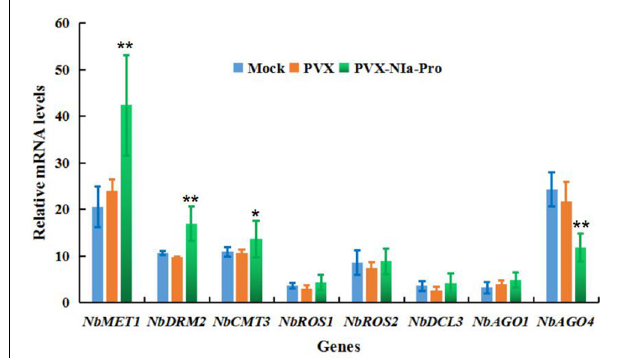
FIGURE 6 | Overexpression of NIa-Pro represses transcription of Nicotiana benthamiana ARGONAUTE 4 (NbAGO4) mRNA. The effects of NIa-Pro on the expression of DNA methyltransferases, demethylases, and key genes involved in RNA-directed DNA methylation (RdDM) were analyzed by RT-qPCR. Relative mRNA levels of N. benthamiana DNA METHYLTRANSFERASE1 ( NbMET1 ), NbDRM2 , CHROMOMETHYLASE3 ( NbCMT3 ), REPRESSOR OF SILENCING 1 ( NbROS1 ), NbROS2 , DICER3 ( NbDCL3 ), ARGONAUTE 1 ( NbAGO1 ), and NbAGO4 were measured in potato virus X (PVX)-NIa-Pro and PVX vector-infected N. benthamiana plants at 15 days post inoculation (dpi). Each mean value was derived from nine plants in three independent experiments. Student’s t -test was performed to assess differences between PVX-NIa- and PVX vector-infected plants. Values are the mean ± SD. Significant differences ( * p < 0.05) and highly significant differences ( ** p < 0.01) between samples in each pair are